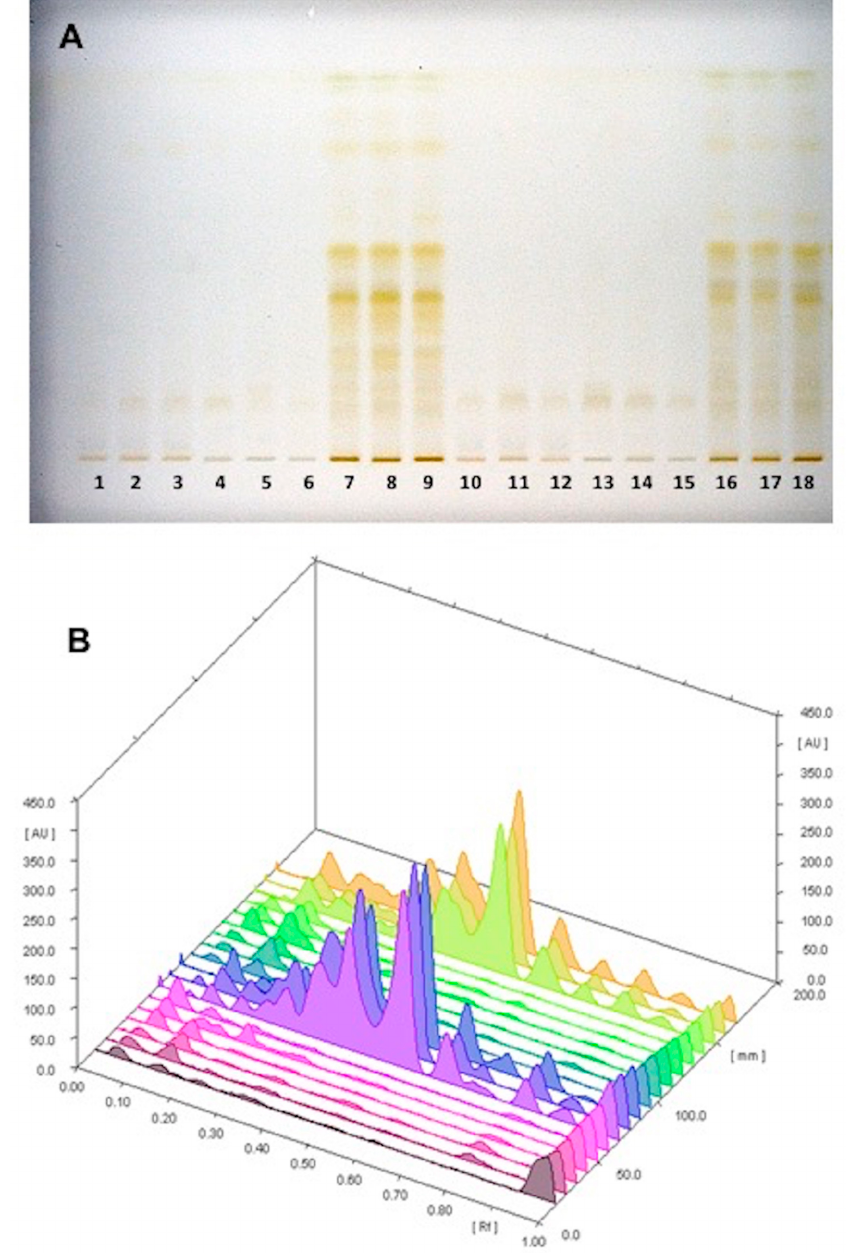
Figure 1. High Performance Thin Layer Chromatography (HPTLC) fingerprint ( A ) and three-dimensional (3D) densitograms ( B ) of Arbutus unedo samples (red fruit, yellow fruit, and leaves) from di ff erent places of collection (Sassari (SS) and archipelago of La Maddalena (LM)). 1. Red fruit LM 1; 2. Red fruit LM 2; 3. Red fruit LM 3; 4. Yellow fruit LM 1; 5. Yellow fruit LM 2; 6. Yellow fruit LM 3; 7. Leaves LM 1; 8. Leaves LM 2; 9. Leaves LM 3; 10. Red fruit SS 1; 11. Red fruit SS 2; 12. Red fruit SS 3; 13. Yellow fruit SS 1; 14. Yellow fruit SS 2; 15. Yellow fruit SS 3; 16. Leaves SS 1; 17. Leaves SS 2; 18. Leaves SS